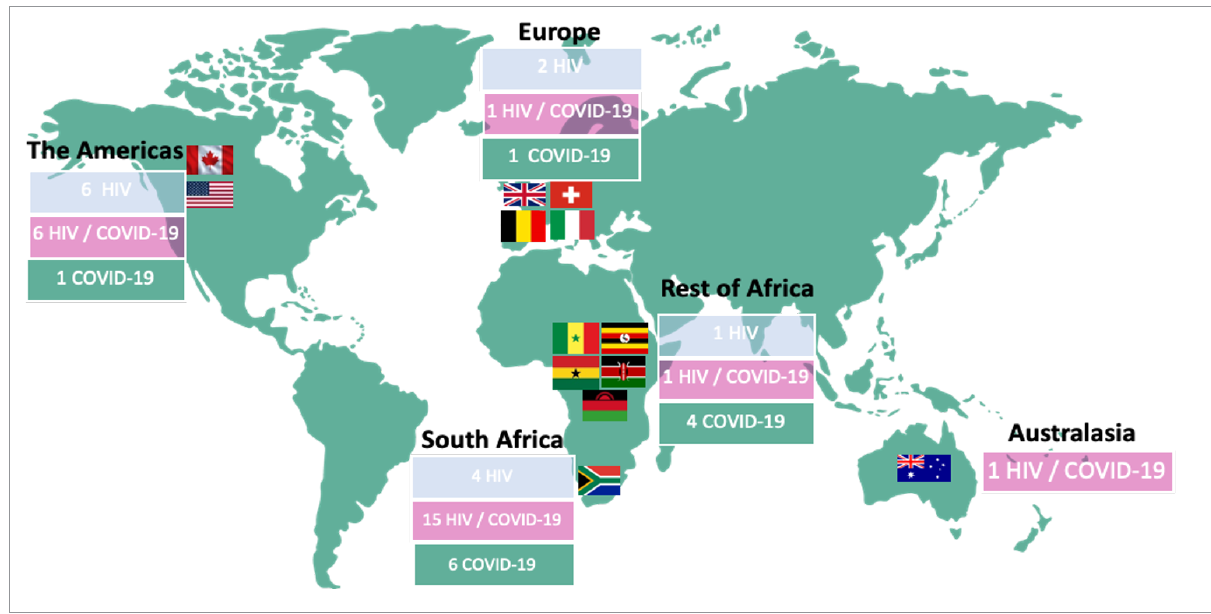
Figure 3: Map of global collaborations. One of the reasons for the success of the Laboratory is our collaborations which span across the globe and across disciplines. We have established HIV-related collaborations (blue), COVID-19-related collaborations (green) and collaborations which span both HIV and SARS-CoV-2 viruses (pink). The number of collaborators in each region is shown as a number in each box. The location of the collaborators is shown by a flag on the continent. this emergency short-term funding has been crucial and timely, sustainable funding will be essential to ensure that research efforts are not jeopardised once the pandemic